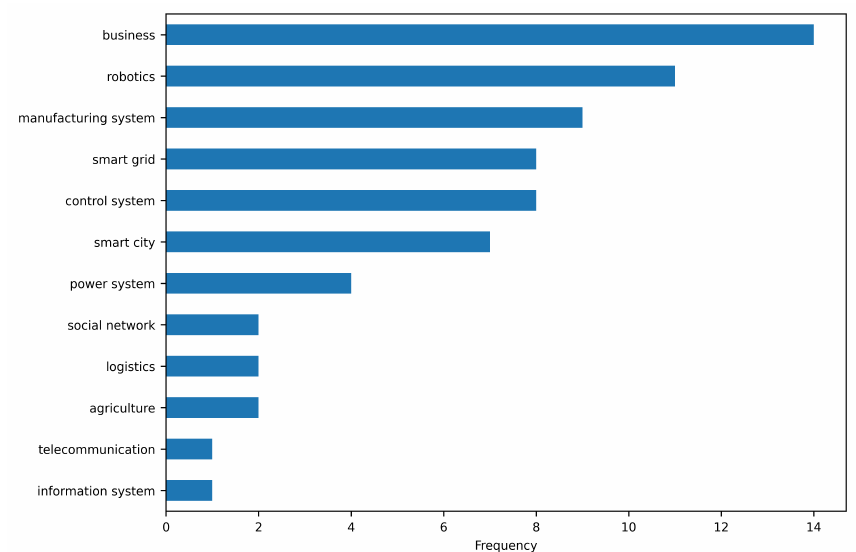
Figure 7. Application sectors of collective intelligence.